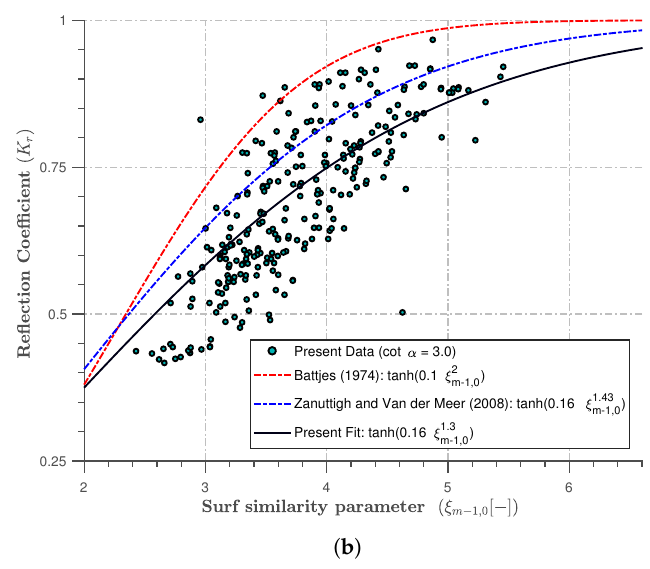
Figure 9. A representation of the non-linear multi-regression fit between K r and ξ m − 1,0 for the sloping seawall with: ( a ) cot α = 1.5; ( b ) cot α =